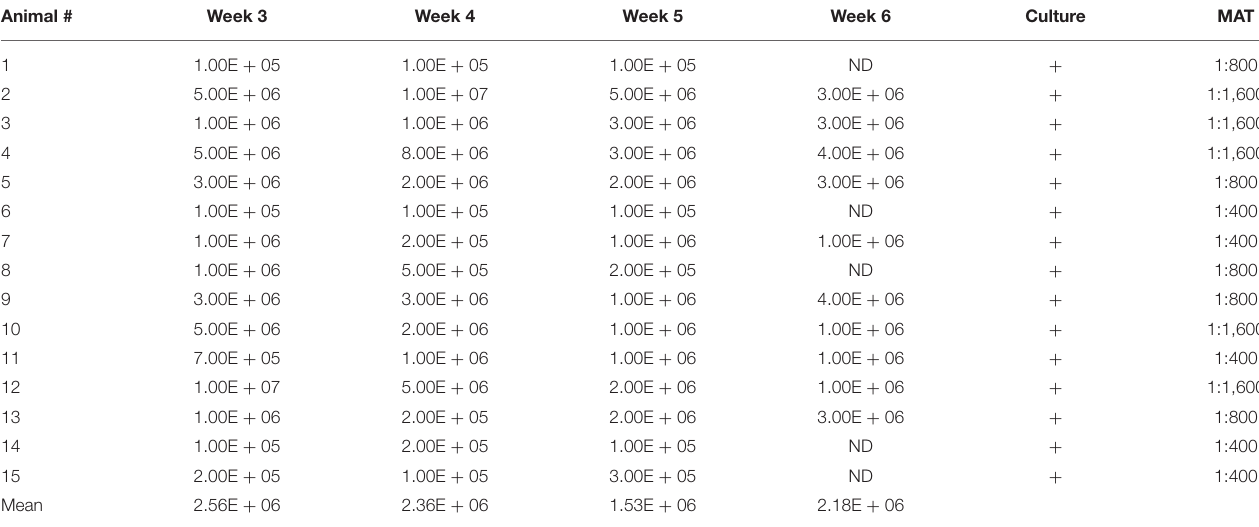
TABLE 1 | Experimentally infected rats were positive for persistent renal leptospirosis. Animal # Week 3 Week 4 Week 5 Week 6 Culture